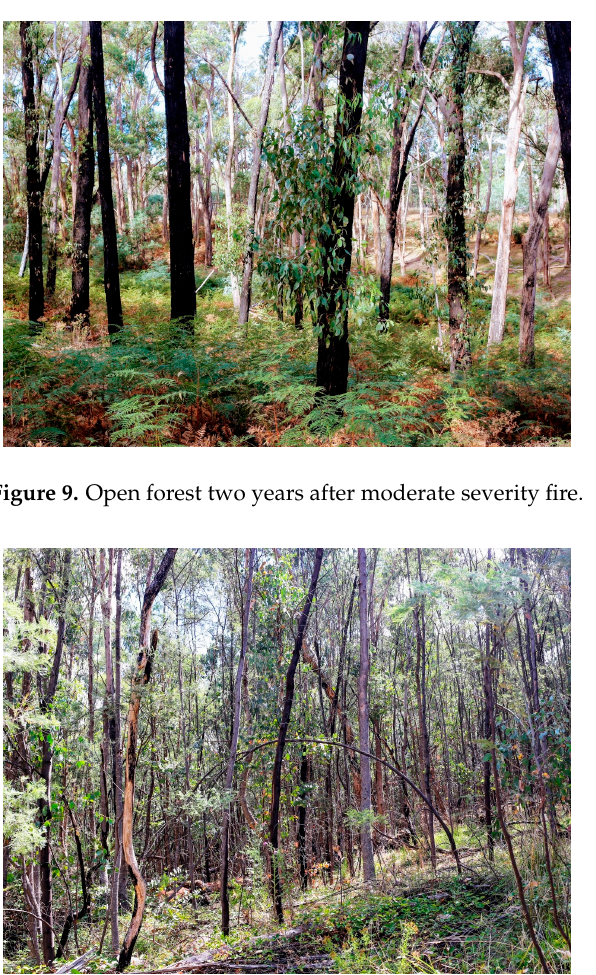
Figure 10. Closed forest nine years after high severity (stand replacement) fire.